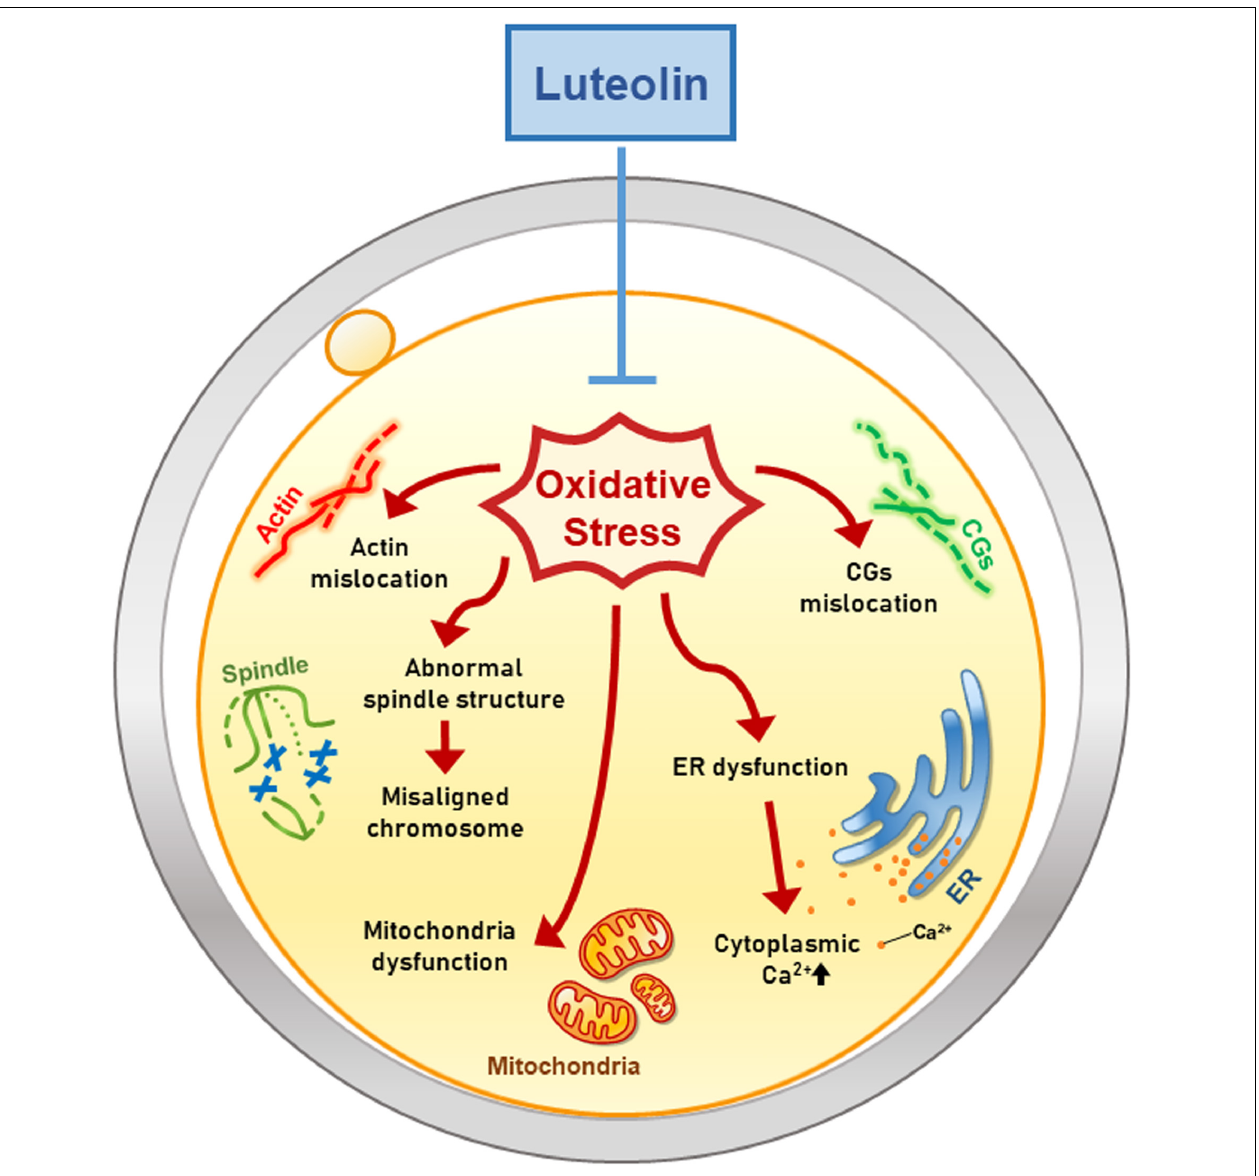
FIGURE 7 | Hypothetical model of the antioxidant effect of Lut on porcine oocyte maturation. Lut improves the quality of porcine oocytes by alleviating oxidative damage. Especially, Lut recovers disrupted organelle dynamics including mislocation of actin, spindle, chromosome and CGs, and dysfunction of mitochondria and ER. These findings suggest that Lut improves porcine meiotic progression and subsequent embryonic development by protecting various organelle dynamics against oxidative